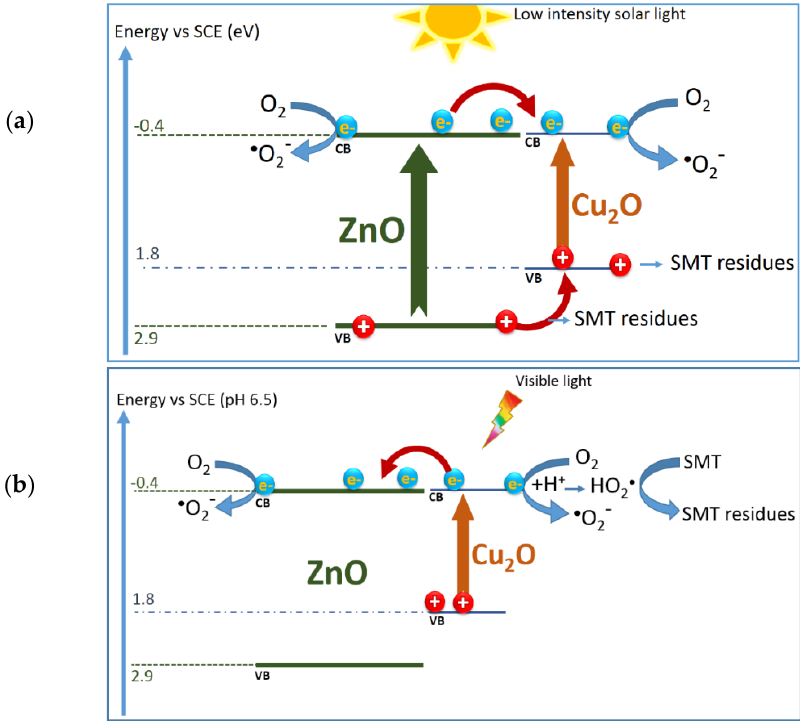
Figure 11. Suggested interfacial charge transfer mechanism (IFCT) during the SMT degradation on ZnO/Cu x = 1.25 O under ( a ) simulated solar light and ( b ) visible light at pH 6.5. Scheme 2 shows the SMT functional group coordination with ZnO and ZnO/CuO. Low potential